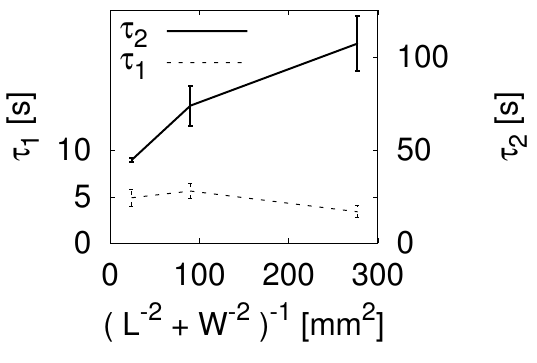
Figure 1. Relaxation times τ 1 (left axis) and τ 2 (right axis) as a function of ( L − 2 + W − 2 ) − 1